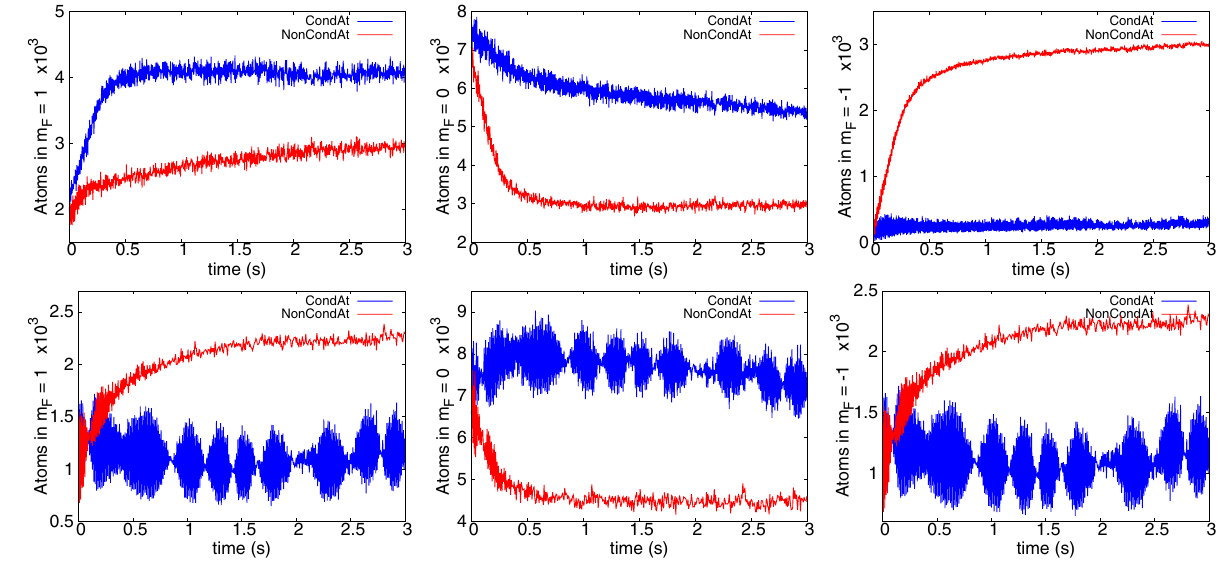
0.2 (cid:31) ω x (B = 425 mG), = 0 but 12% of initial = 0 in the =